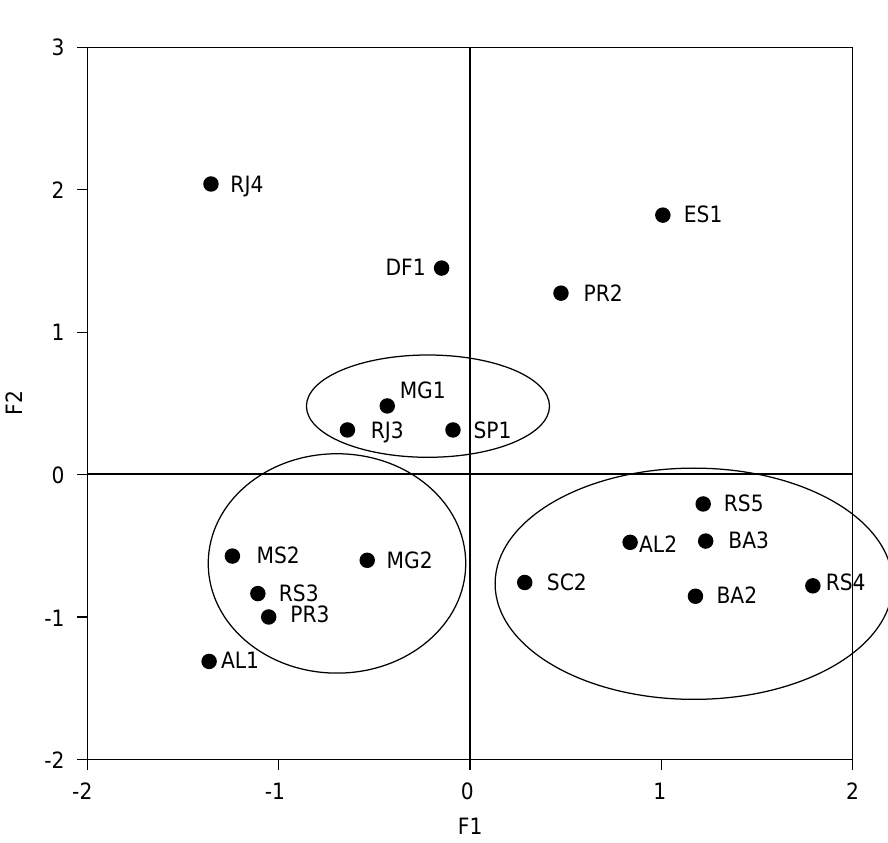
Figure 2. Clusters of Brazilian Organosol profiles according to carbon and nitrogen stocks, obtained by principal component analysis with varimax